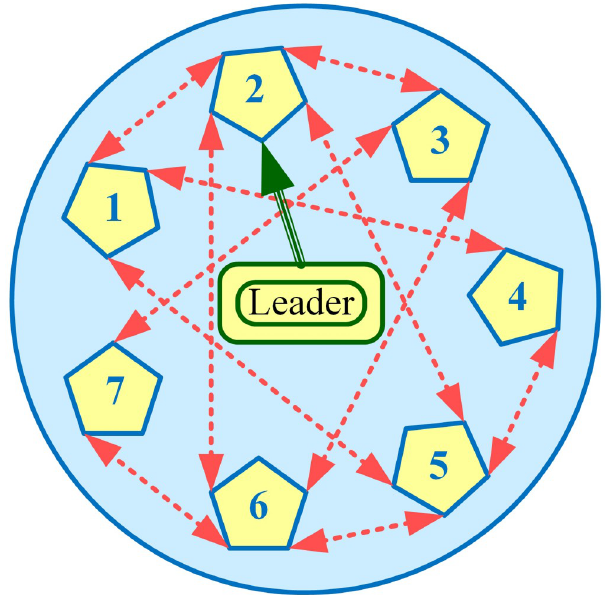
Fig 3. Communication graph of the